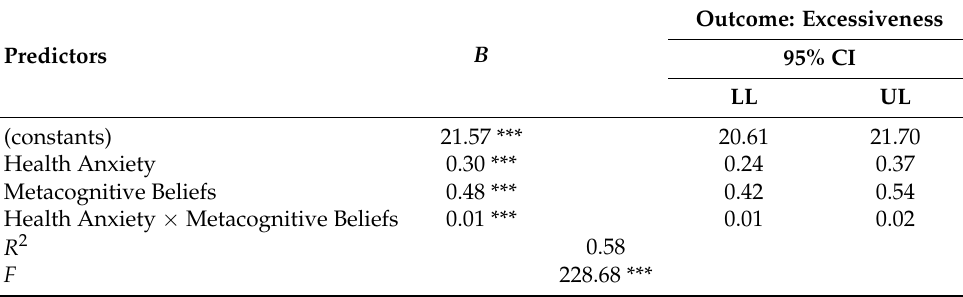
Table 7. Moderation of metacognitive beliefs between health anxiety and excessiveness (cyberchon- dria construct) ( N = 500).